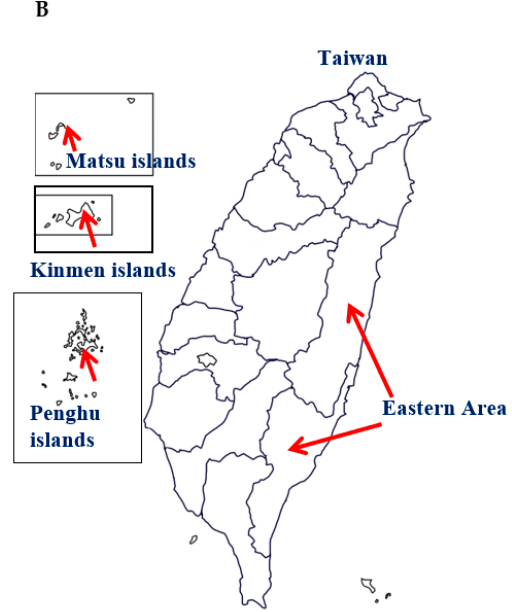
Figure 3. Major outbreak area of scrub typhus in Taiwan between 2010 and 2019. ( A ). Incidence of confirmed cases of scrub typhus in Taiwan according to region. ( B ). the major outbreak area is represented by the red line.